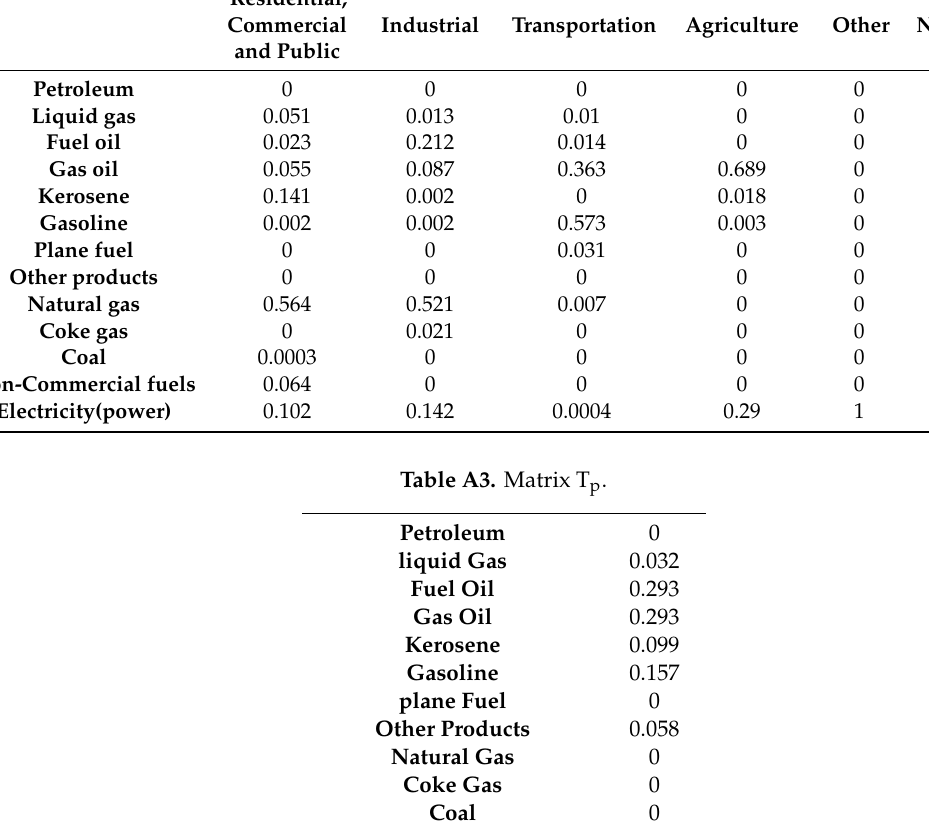
Table A2. T 1,2 matrix.